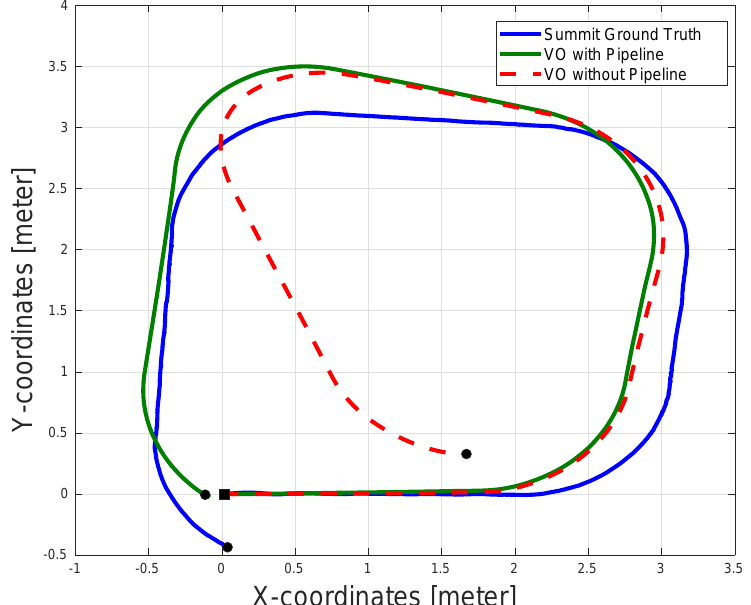
Figure 11. The pose estimation results for a rectangular sequence executed by Summit XLS steel. The figure shows the output of the VO with and without the proposed pipeline. The VO with the pipeline shows better pose accuracy especially at the end of the sequence while the VO without the pipeline suffers from significant amount of drift error. The black square represents the start of the paths and the black circles represent the ends of the